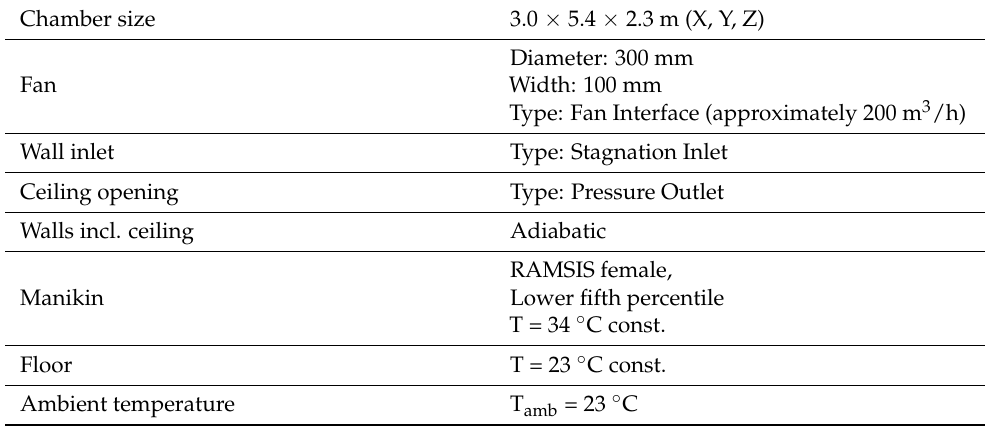
Table 5. Boundary conditions and parameters for the environmental